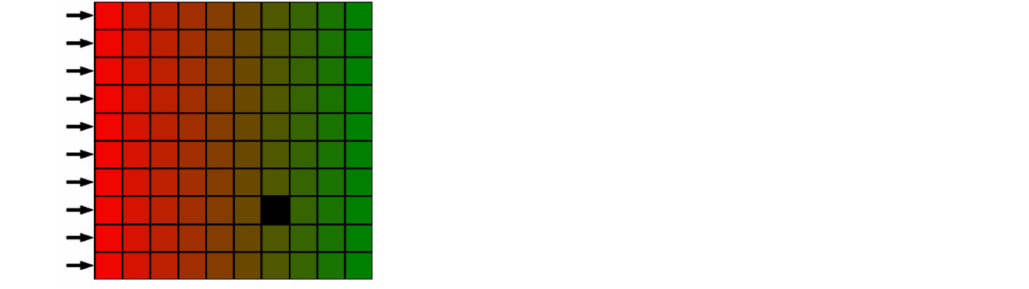
Figure 4. Visualisation of the importance weight in a 2D workspace with one access plane (depicted by the black arrows).